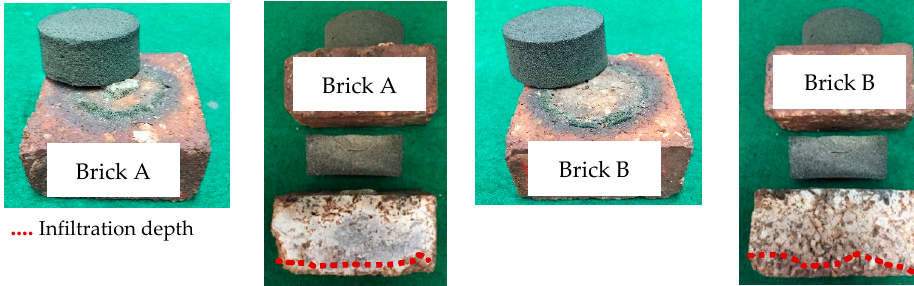
Figure 4. Visual aspect and cross section of the bricks A and B after 3 cycles of contact coating test using cement raw meal as received.